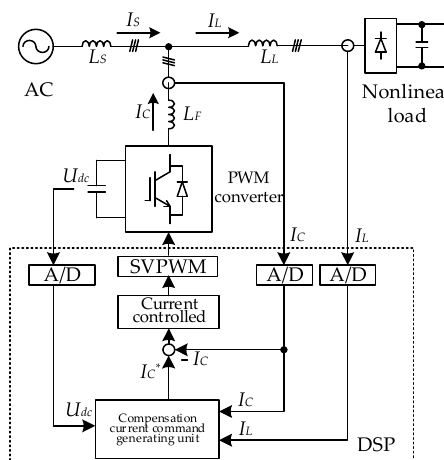
Figure 9. Control block diagram of parallel APF.